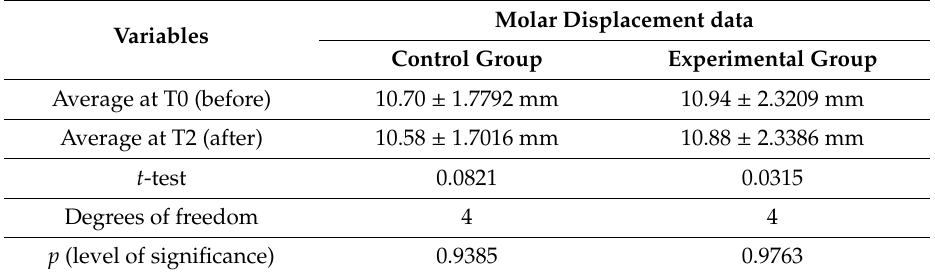
Table 3. Average Position of the First Molars (mm) Before (T0) and After 1 Month of Follow-Up